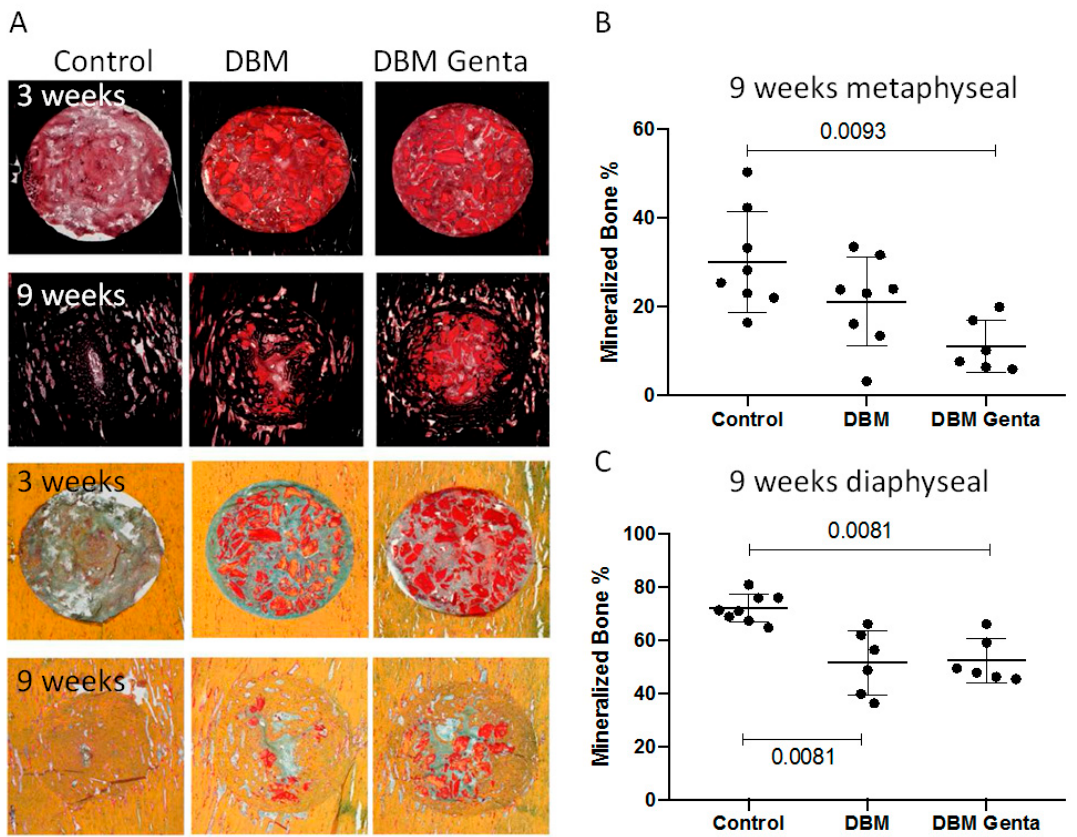
Figure 3. Exemplary histological pictures of the diaphyseal drill hole defects. Tissue was stained with Safranin O/van Kossa ( A , top) to visualize the mineralized bone, or with Movat Pentachrome ( A , bottom) to differentiate the tissues. Healing progressed from week three to week nine in all groups, with less healing in the gentamicin-treated defects. ( B , C ) Histomorphometric analysis: After nine weeks, significantly less mineralized tissue was formed in the gentamicin-loaded DBM group, both metaphyseal and diaphyseal. Diaphyseally, significantly less bone was formed in the DBM group compared to control. Kruskal-Wallis test with Dunn´s (n = 6–8 per group and time point) .